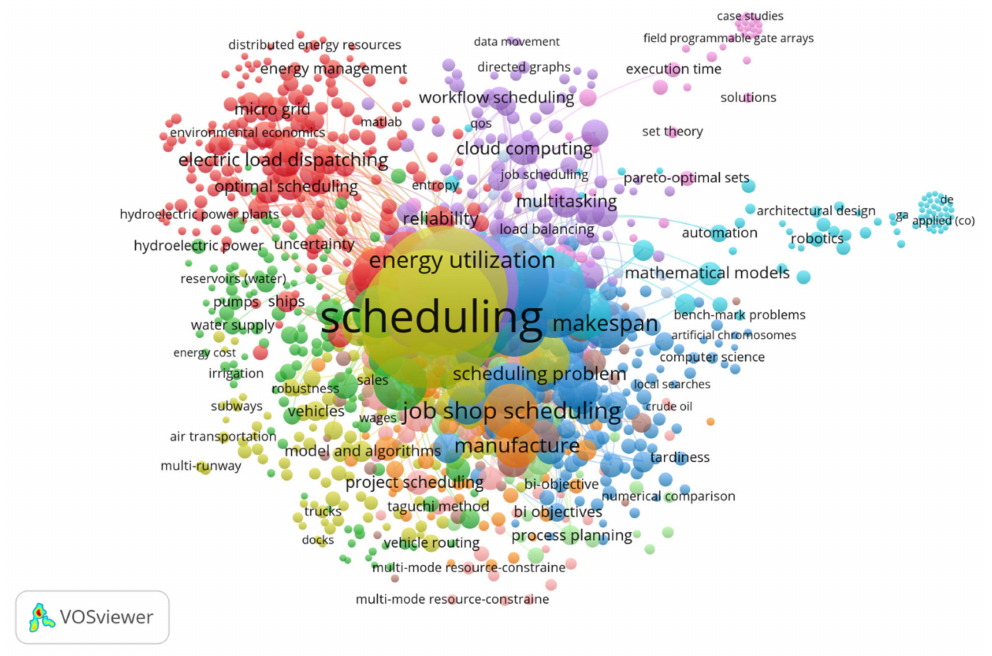
were used earlier (around 2012).